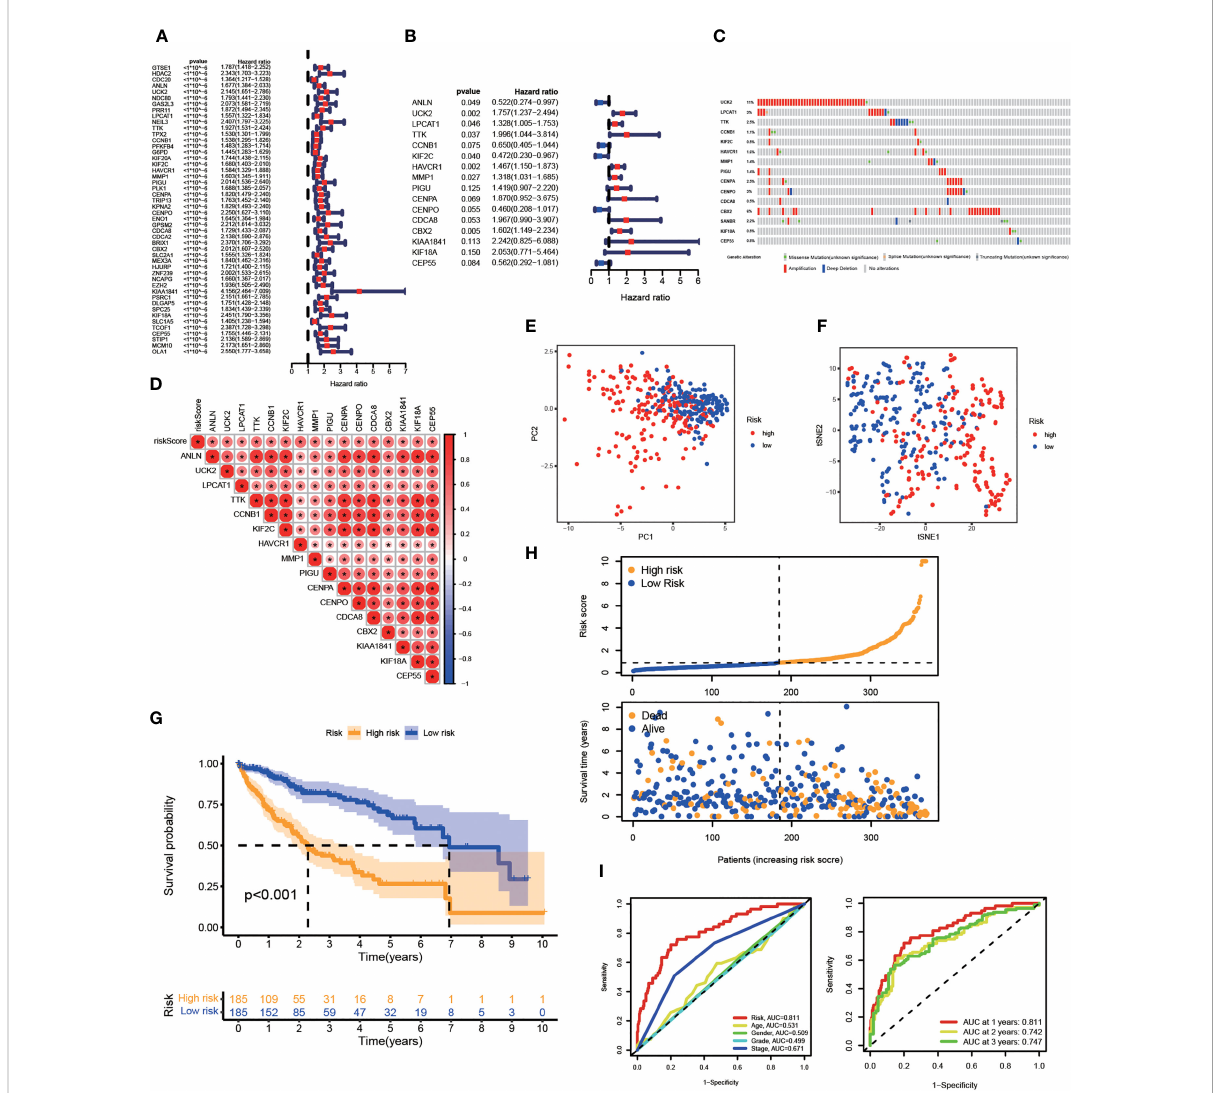
FIGURE 4 Establishment of A Prognostic Risk Model in TCGA-LIHC Cohort. Construction of a FA metabolism-related model in TCGA. (A) Univariate Cox regression analysis to fi nd FA metabolism-related prognostic genes. (B) Multivariate Cox regression analysis to identify genes linked to the prognosis of FA metabolism. (C) The distribution of 16-gene genomic alterations in the TCGA-LIHC dataset. (D) Spearman correlation analysis of 16 genes. PCA analysis (E) and t-SNE analysis (F) based on risk scores. (G) The KM analysis of the OS based on risk scores. (H) Survival status distribution of these two groups. (I) ROC curve showing the accuracy of risk scores on the clinical parameters and year survival rate (*p < 0.05, **p < 0.01, ***p <